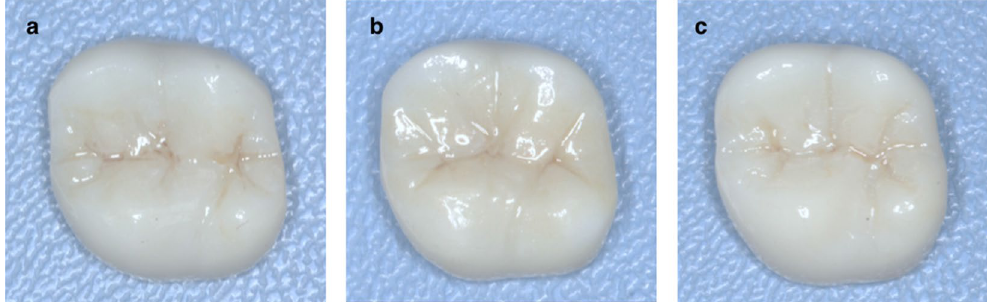
Figure 1. Example of the crowns designed differently in the study. ( a ) The ceramic crown designed by FGP technique (FGP). The crown was a copy of the interim made in the participant’s mouth by the FGP technique. ( b ) The ceramic crown designed with the average-value virtual articulator (AVR). ( c ) The ceramic crown designed by conventional fabrication (CON), which was fabricated by the technician from his own experience in the CAD/CAM software.